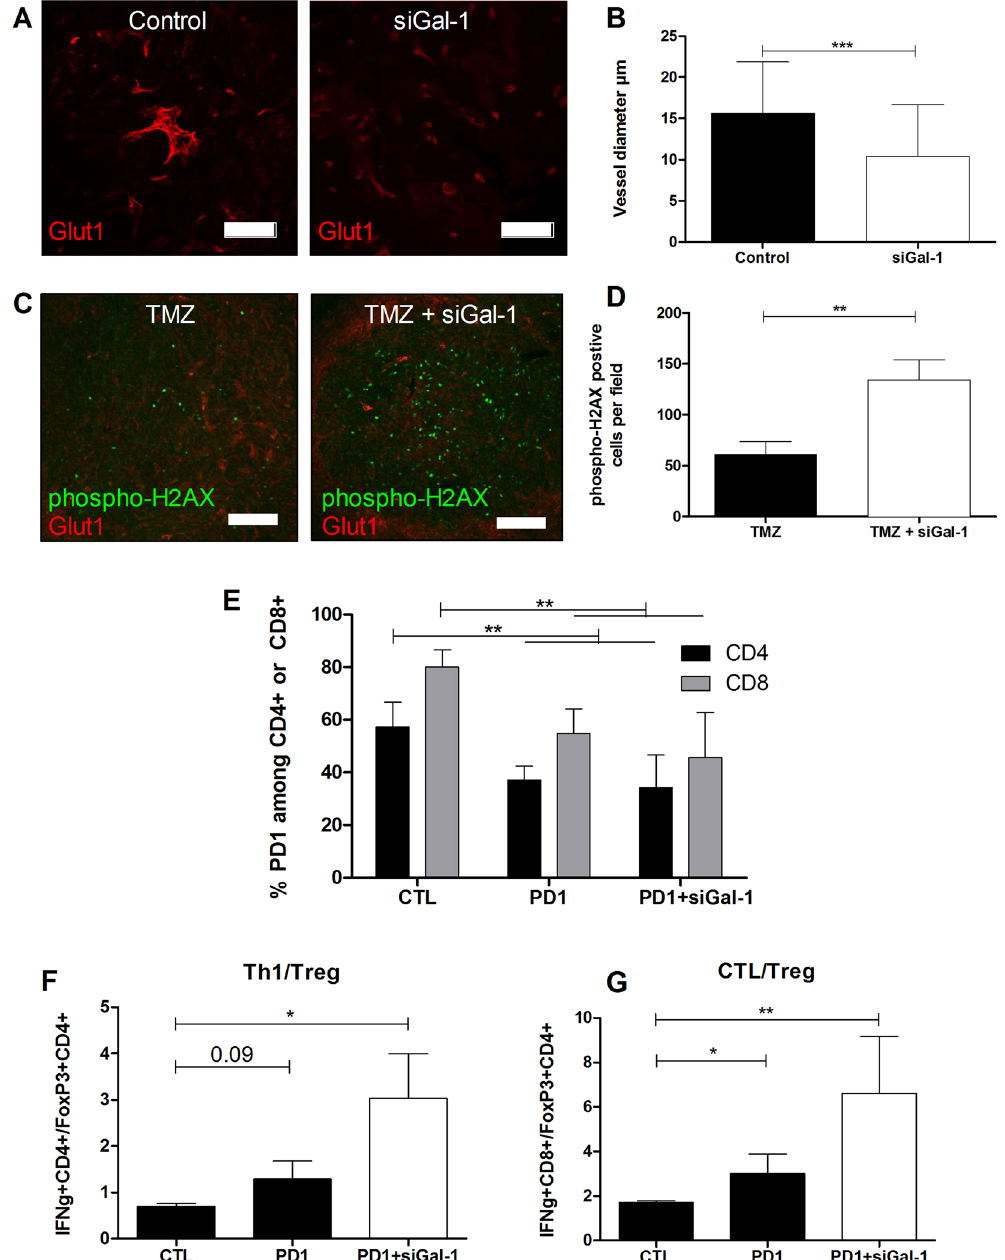
Figure 4. Mechanistic insights explaining synergistic effects of siGal-1 with chemo and immunotherapy. Mice were inoculated with 0.5 × 10 6 GL261 cells which induce a lethal GBM after 15–20 days. ( A ) Mice were left untreated (left panel), treated with siGal-1 on day 4, 8, 12 and 15 after tumor inoculation (right panel), and stained for GLUT-1 (red), which stains vasculature. ( B ) Quantification revealed signficantly enlarged vasculature in untreated mice. (n = 5/group, ** p < 0.01). ( C ) TMZ induced DNA damage was measured by phospho-H2AX staining (green), which (D) indicated a significant higher DNA damage pattern if mice were pre-treated with siGal-1. (n = 3/4/group, ** p < 0.01). ( E ) Analysis of brain infiltrating lymphocytes during anti-PD-1 therapy (at day 7 and 12 after tumor inoculation, 100 µ g/day), at day 18 post tumor inoculation, revealed a significant decrease of PD-1 expression on CD4 + (black bars) and CD8 + (gray bars) lymphocytes. In ( F ) the ratio immune activation to immune suppression was calculated for Th1 (IFN γ+ CD4 + CD3 + CD45 + ZY − ) and CTL ( G ) (IFN γ+ CD8 + CD3 + CD45 + ZY − ), as compared to Treg (FoxP3 + CD4 + CD3 + CD45 + ). (n = 5/group, * p < 0.05 and ** p < 0.01). Scale bar: A. 100 µ m; C. 250 µ